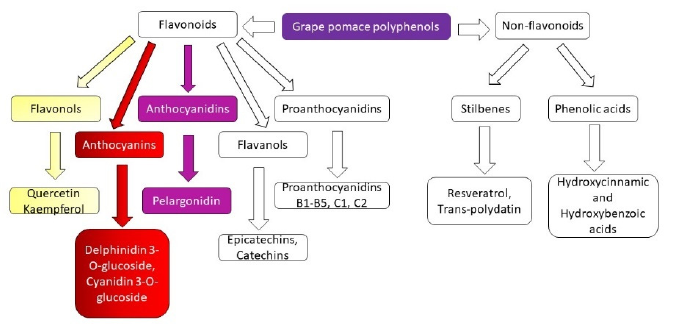
Figure 1. Grape pomace polyphenols classes.